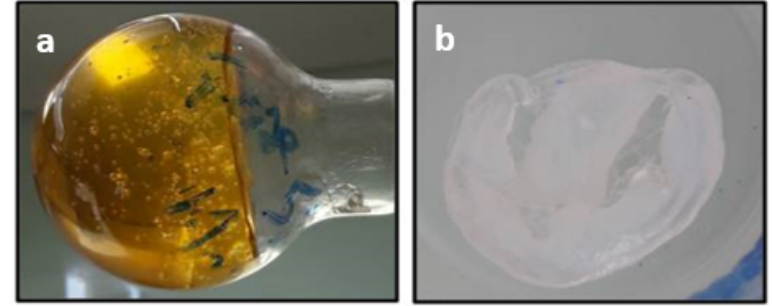
Figure 3. Photographs of: ( a ) dissolved cotton cellulose in [DIMIM][(MeO)(H)PO 2 ] (5 wt%); ( b ) cellulose regenerated in ethanol.